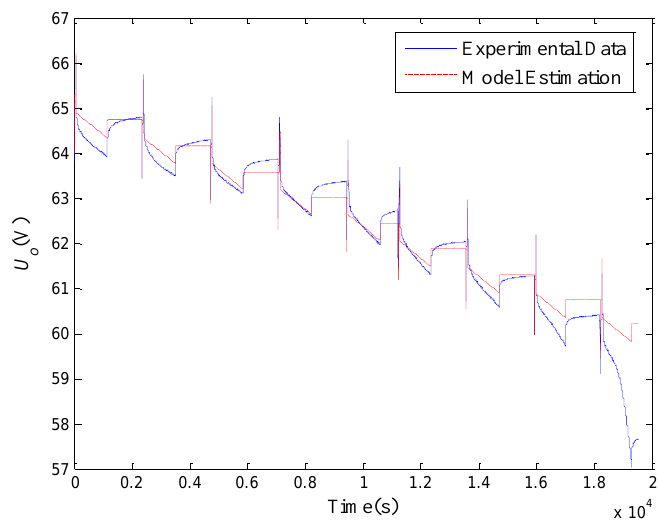
Figure 10. Voltage response of the battery model.